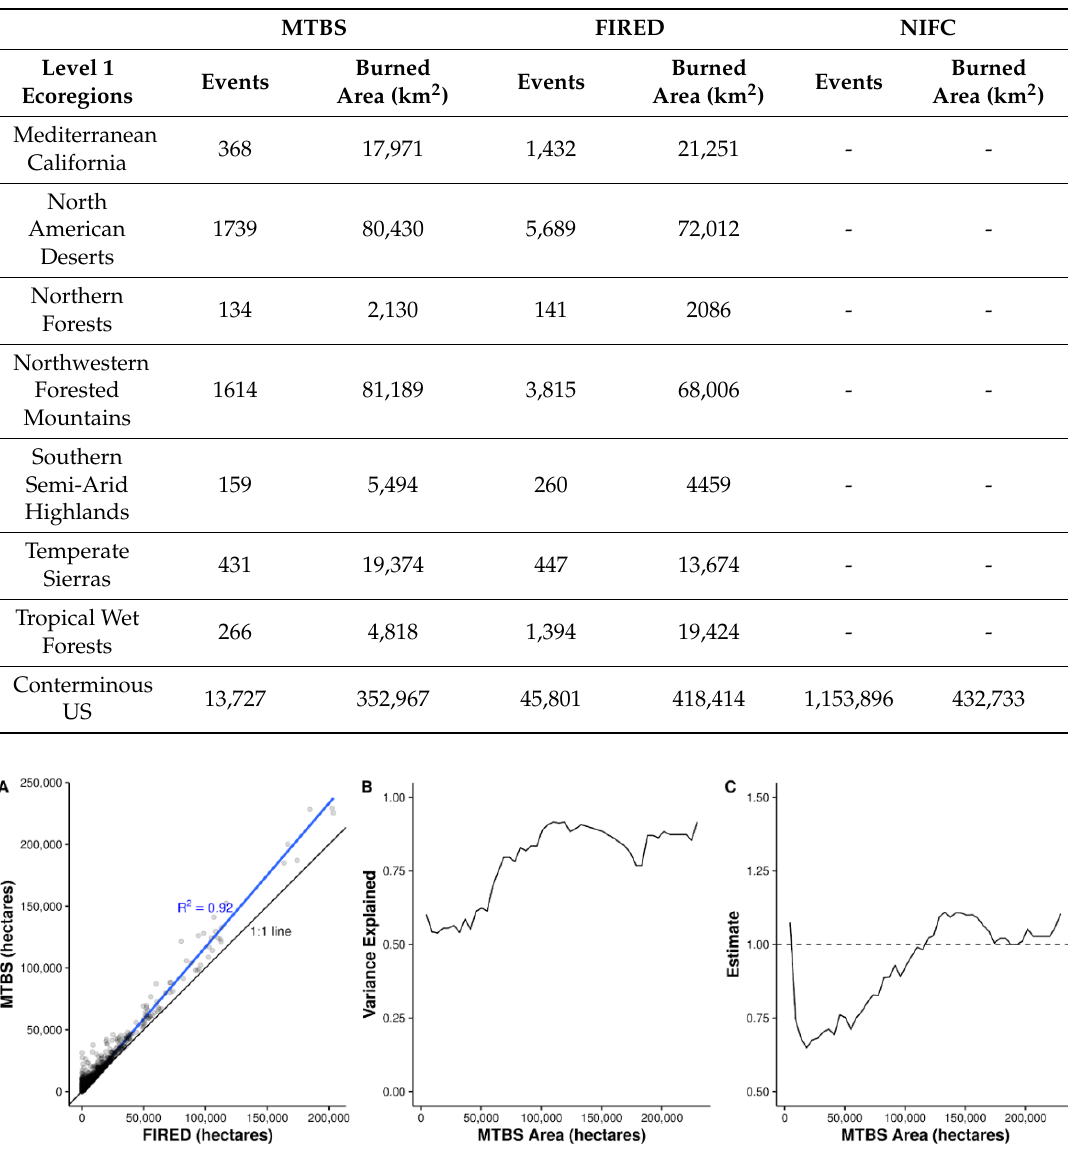
Figure 2. A comparison of burned area for individual fire events delineated by both products. Panel ( A ) shows the relationship between area burned for MTBS and FIRED events. While the relationship is generally strong (R 2 = 0.92 for all events), it is weaker for smaller fires. For panels ( B ) and ( C ), we binned the data into 50 equal size classes (each bin spans ~ 5000 hectares) and ran a linear regression (MTBS burned area predicted by FIRED burned area) on each bin. Panel ( B ) shows the R 2 values, which do not consistently stay above 0.8 until about 70,000 hectares. Panel ( C ) shows the relationship between the slope of the regression line for each size class bin, illustrating that the MODIS MCD64A1 burned area product consistently underestimates burned area for fires below 100,000 hectares, which may be an artifact of MTBS, not including unburned patches within its perimeters.